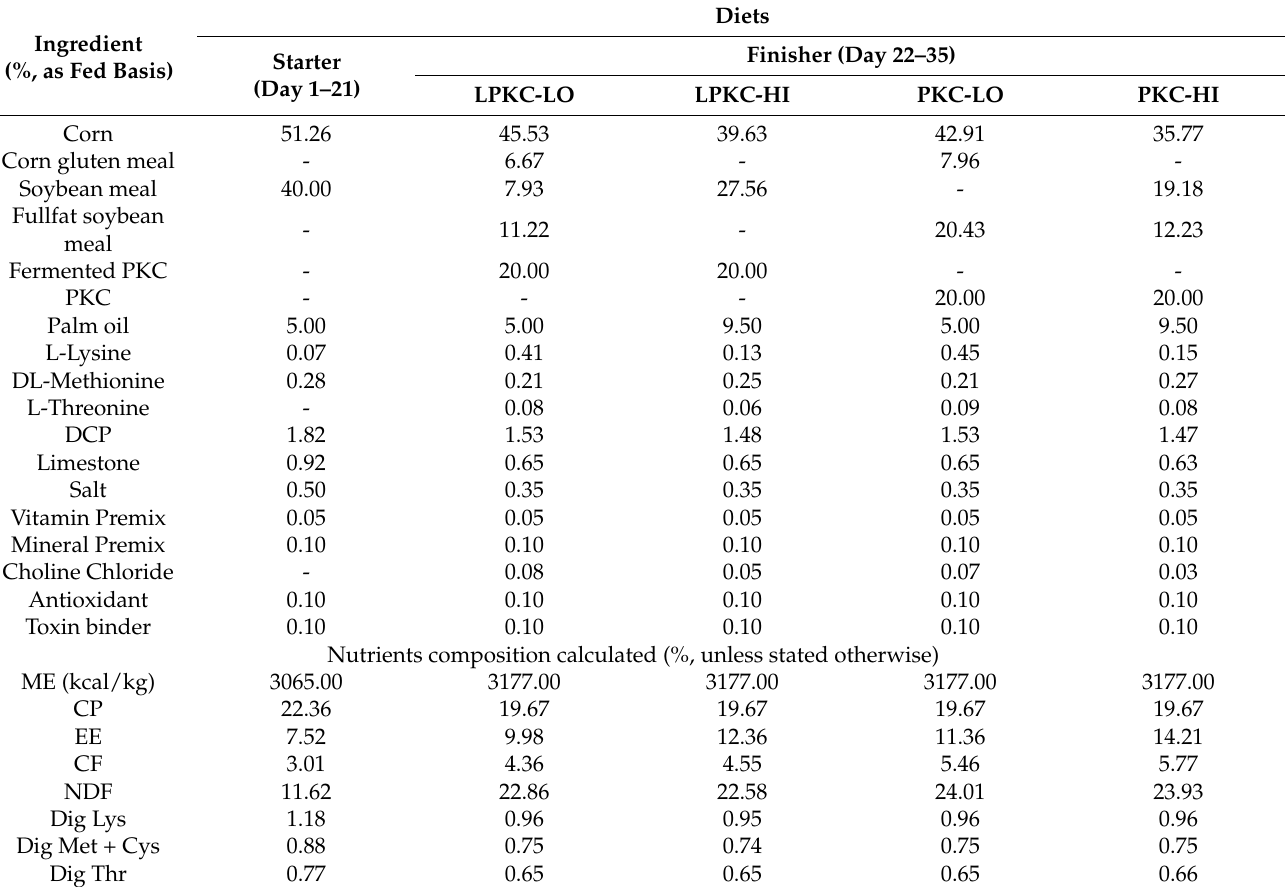
Table 2. Feed ingredients and chemical composition of the starter and finisher broiler